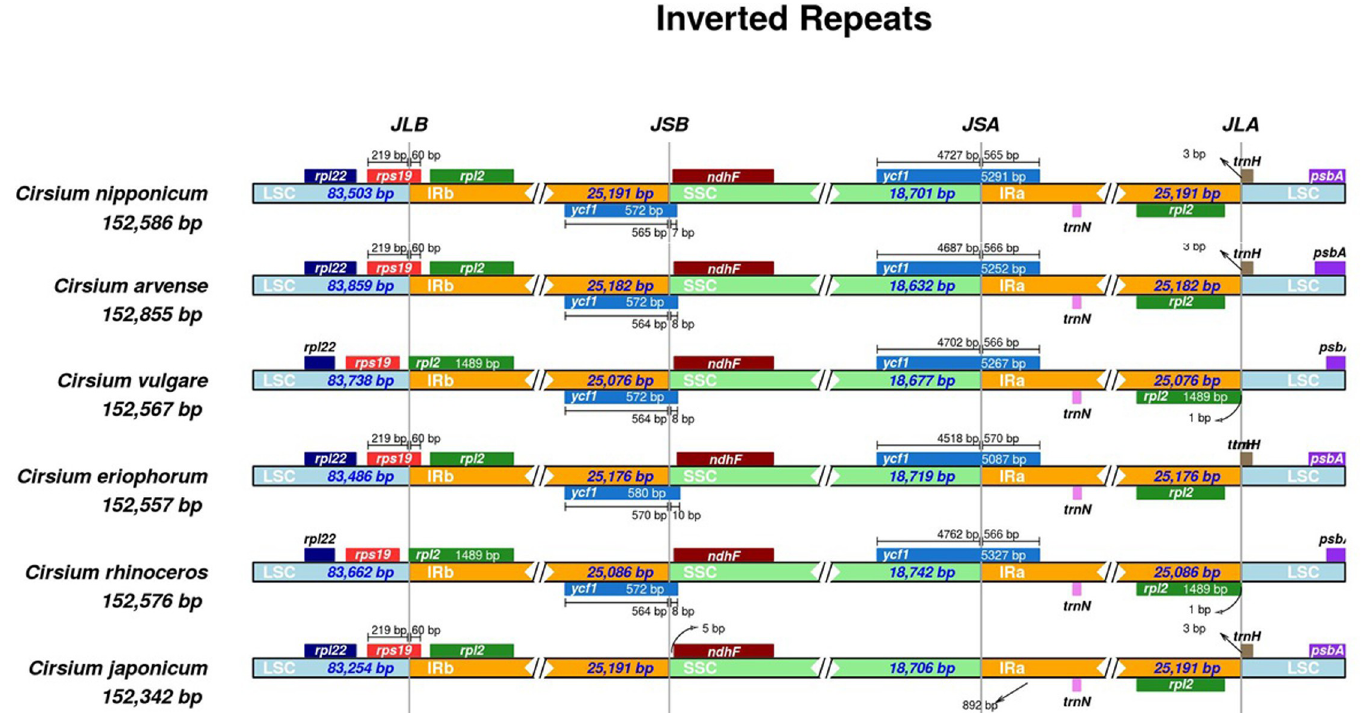
Fig 2. Comparison of the IR regions and the junctions of LSC, IR, and SSC regions among chloroplast genomes of six Cirsium . C . arvnes , C . vulgare , C . eriophorum , C . rhinoceros , C . japonicum have NC_036965.1, NC_036967.1, NC_036966.1, NC_044423.1, NC_050046 accession numbers respectively.